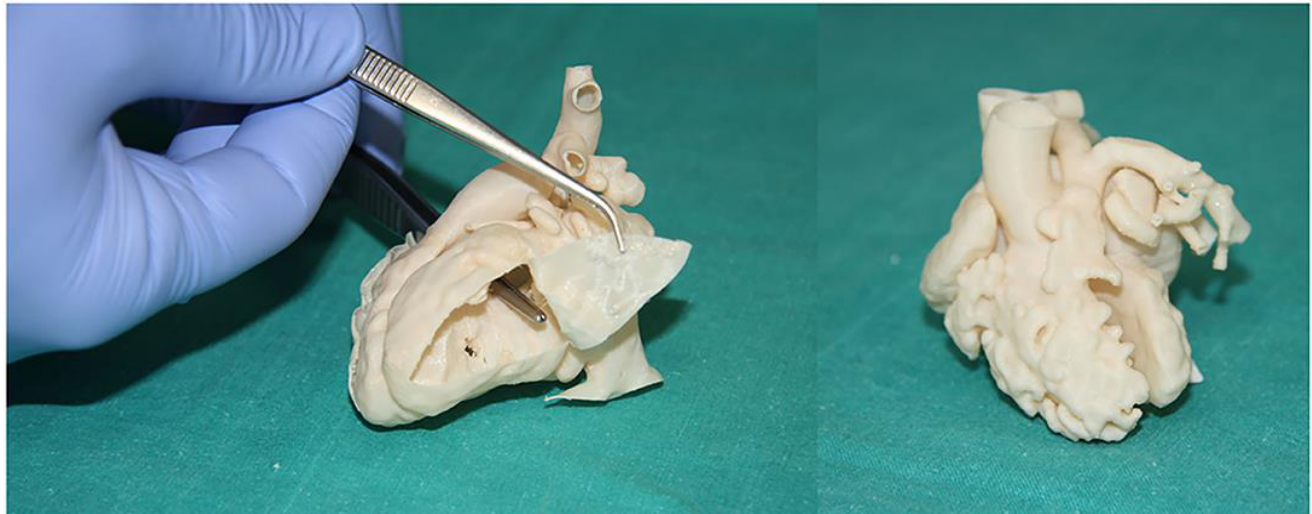
Figure 10. Surgical and interventional planning on 3D-printed heart models. DORV case, internal vision from the left ventricle ( left ). DORV (another case), external view ( right ). DORV-double outlet right ventricle. Reprinted with permission under the open access from Gomez-Ciriza et al. [21].